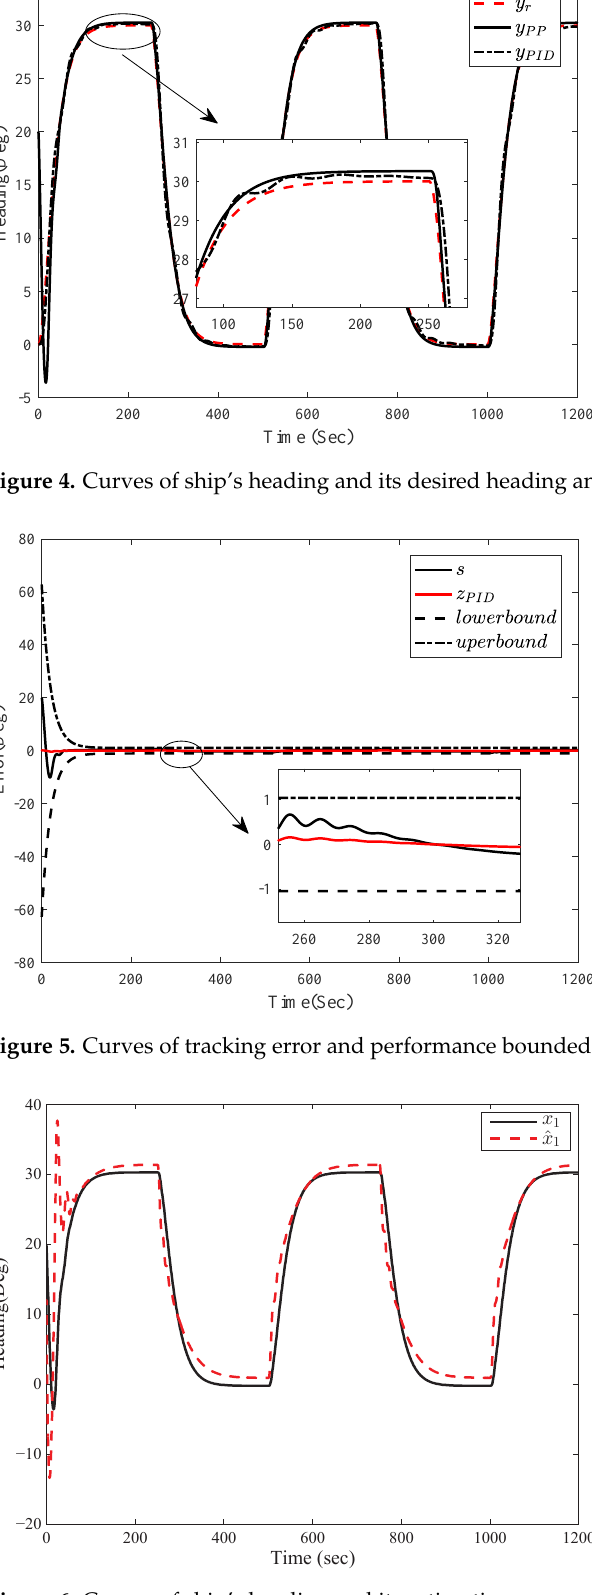
Figure 6. Curves of ship’s heading and its